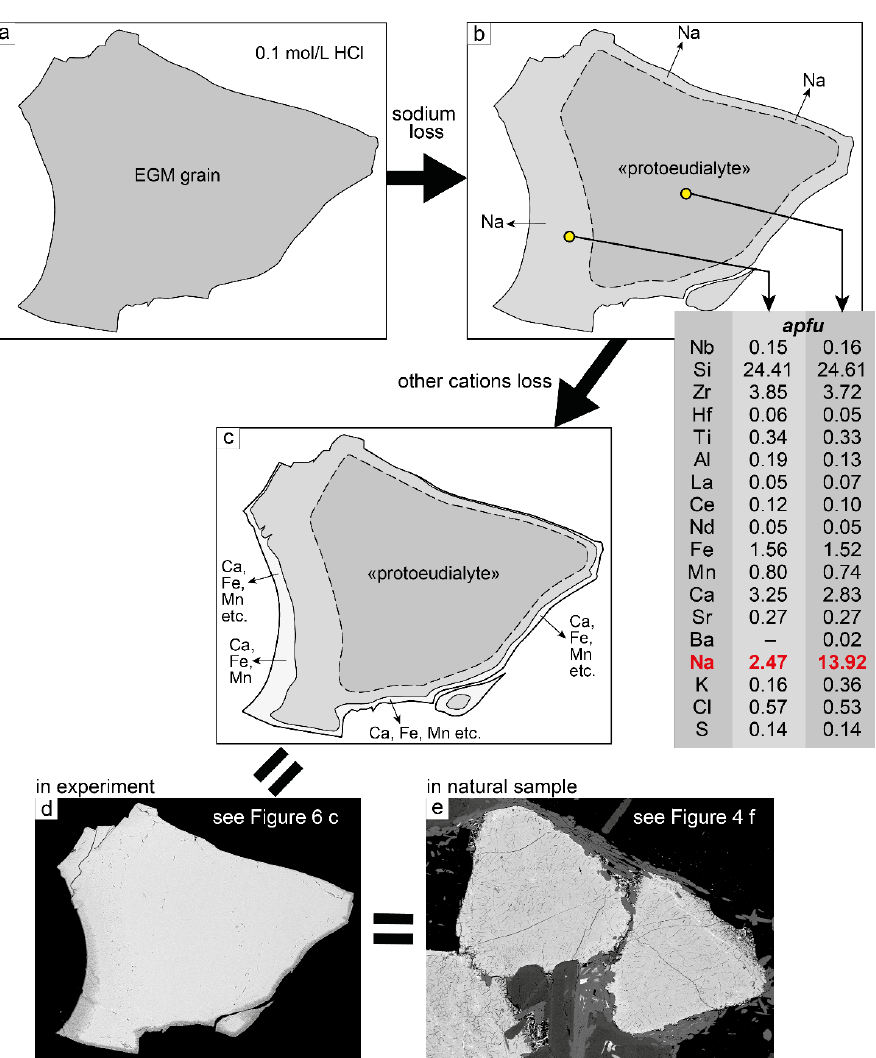
Figure 8. The general scheme of partial dissolution of EGM. ( a ) Start of the experiment: a grain of unaltered EGM is placed in 0.1 mol/L HCl solution; ( b ) loss of sodium from the marginal parts of EGM grain leads to the formation of EGM with extremely low Na content; ( c ) loss of other cations from the edge of the grain; as a result, a rim of the Si-Zr phases is formed; ( d ) EGM grain after experiment; unaltered EGM (in the center), surrounded first by a rim of low-sodium EGM and then by a rim of Si-Zr phase; BSE image; ( e ) EGM, partially dissolved in natural conditions; BSE image. Supplementary Materials: The following supporting information can be downloaded at: